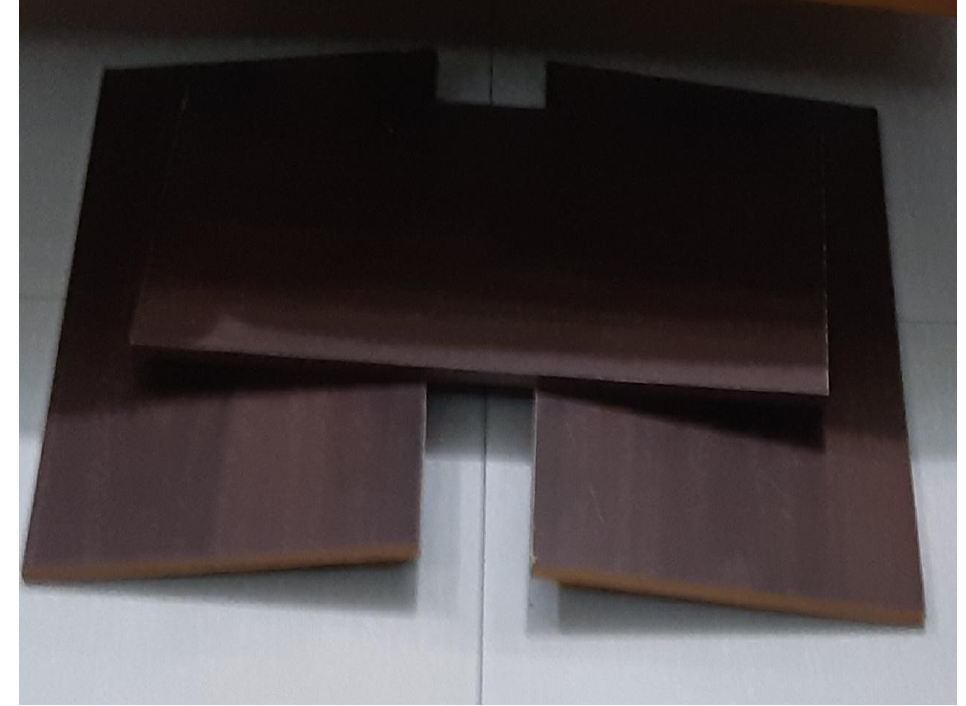
Figure 6. The experimental setup of shielded signals by wood.